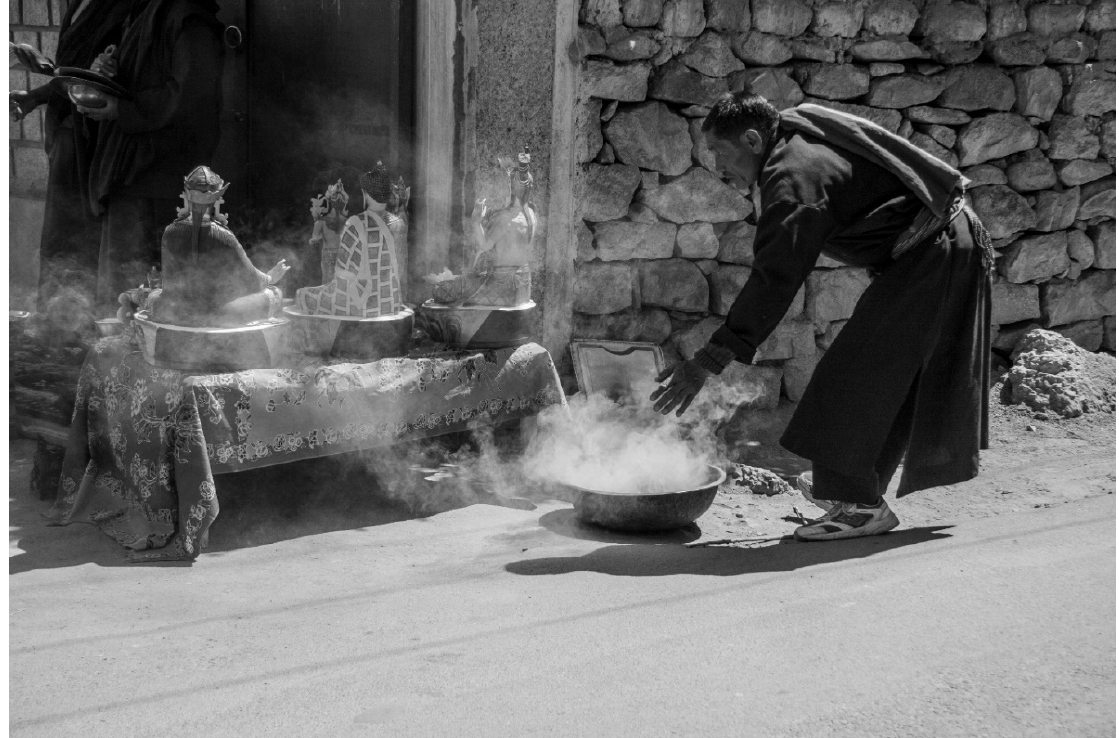
Figure 2. Consecration ceremony for statues, Sankar Gompa, Leh, Ladakh (photo E. Ferrari 2015).